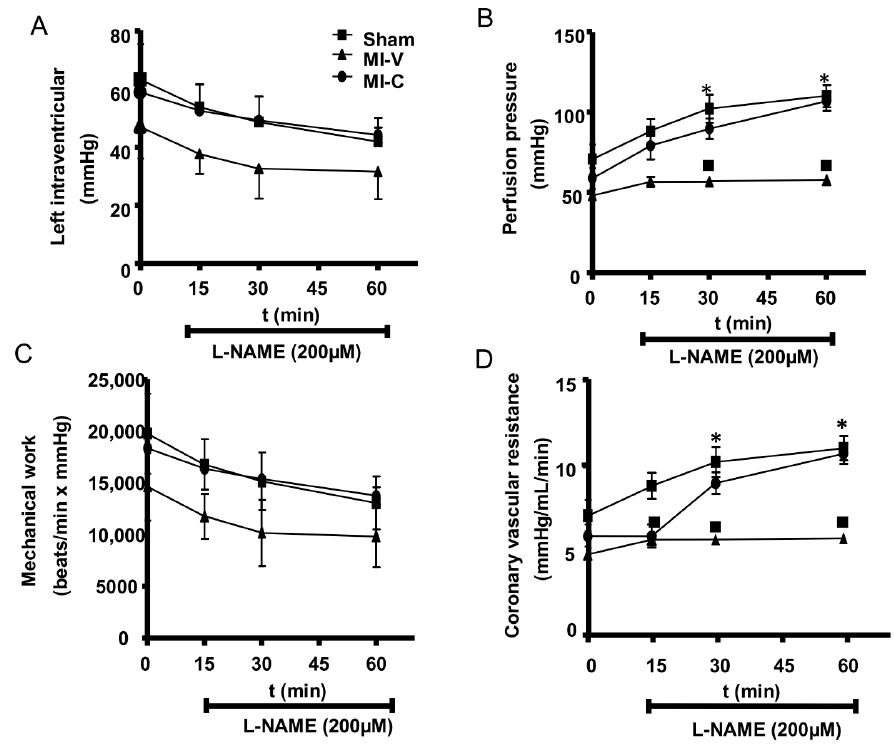
Figure 6. Ex vivo cardiac functioning parameters obtained from Sham, myocardial infarction vehicle (MI-V)- treated, and MI-clofibrate (MI-C)-treated rats. The following parameters were evaluated under basal conditions or in presence of N( ω )-Nitro-L-arginine methyl ester (L-NAME, 200 µ M): ( A ) Left intraventricular pressure, ( B ) perfusion pressure, ( C ) mechanical work, and ( D ) coronary vascular resistance. Squares represent Sham group, triangles represent MI-V group, and circles represent MI-C group. Bars represent the mean ± standard error. ANOVA * p < 0.05 vs. Sham; ■ p < 0.05 vs. MI-V; n = 3 rats per group.